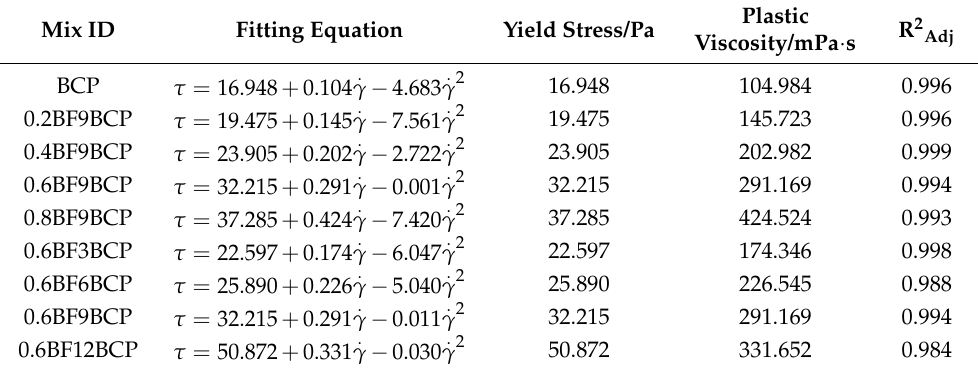
Table 4. Fitting analysis of the modified Bingham rheological model.